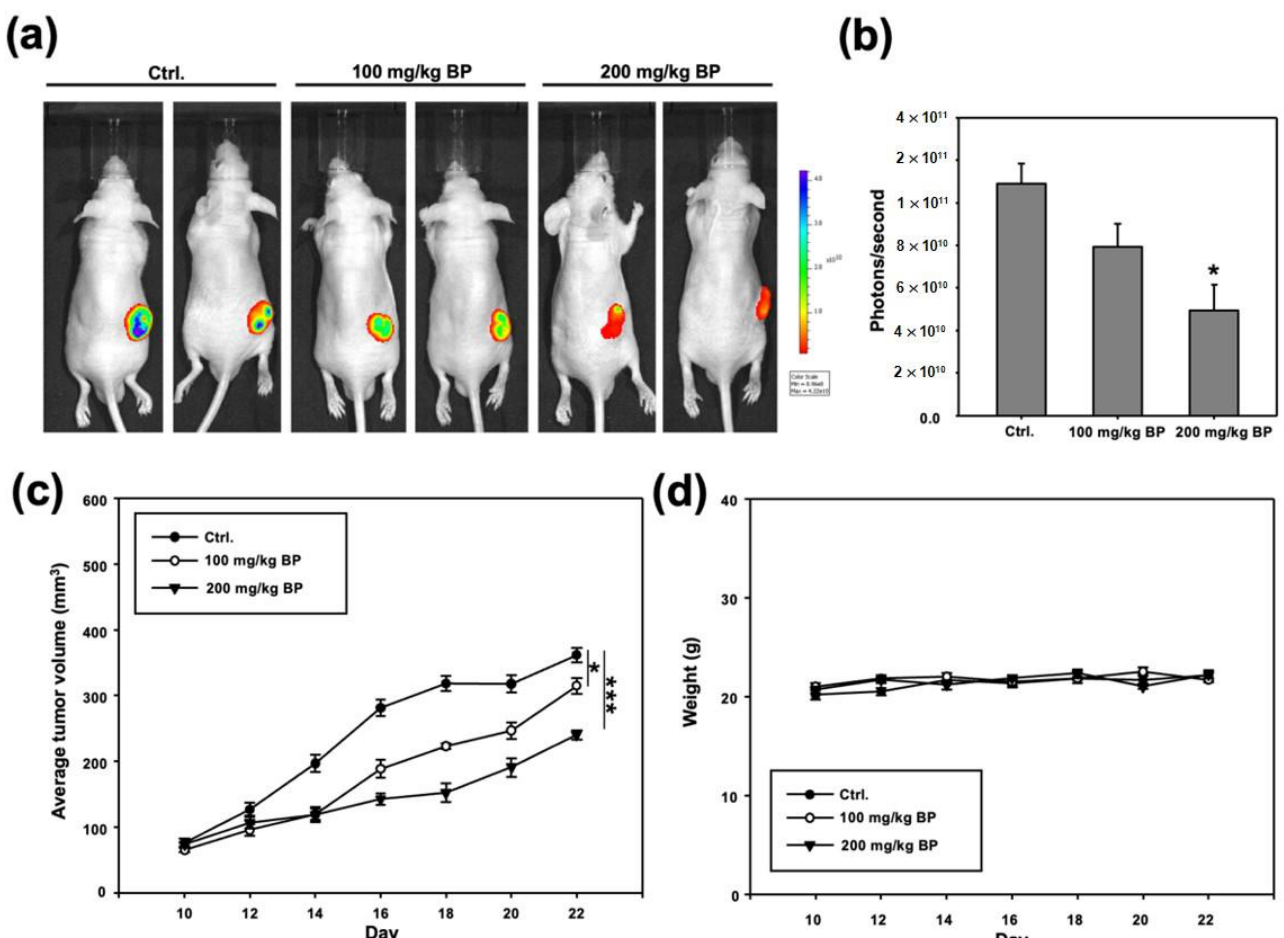
Figure 4. Butylidenephthalide inhibits in vivo tumorigenicity in the ALDH1 + /CD44 + -1-transplanted immunocompromised mice. After implantation of ALDH1 + /CD44 + cells subcutaneously, BALB/c nude mice receiving various concentrations of butylidenephthalide were analyzed for the bioluminescence signal using IVIS imaging system. ( a ) The representative image and ( b ) quantitative analysis of signal intensity at day 22 are shown; ( c ) tumor volume; ( d ) body weight. The emitted signal by the implanted cells was monitored for 22 days (each group, n = 5). Results are means ± SD; * p < 0.05 compared to Ctrl (control group; administration with normal saline without butylidenephthalide). Butylidenephthalide (BP).